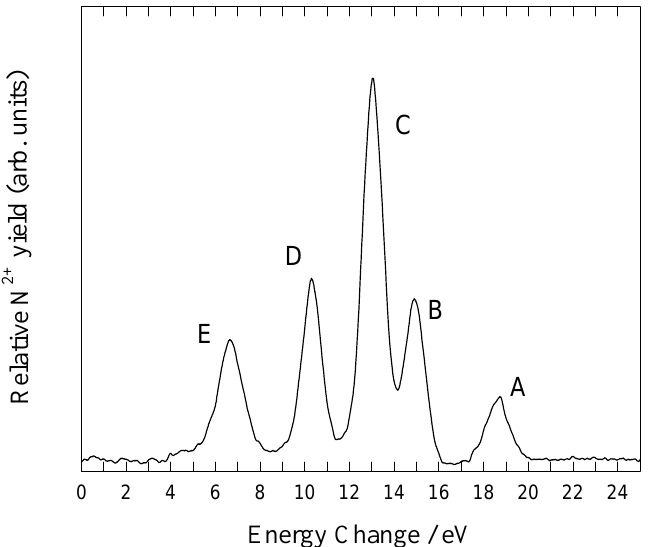
Figure 2: Energy change spectrum for one-electron capture by N 3+ in He at 3 keV [19]. It is possible to select product N 2+ ( 2 P) ions from the main observed